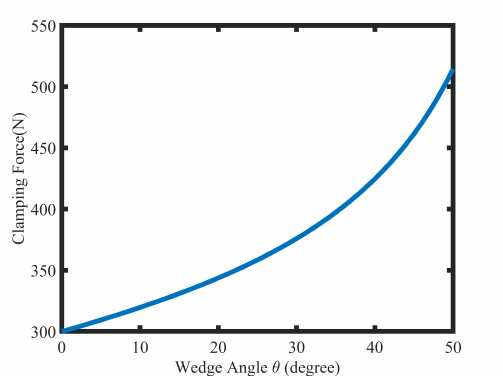
Figure 4. The relationship between the clamping force and the wedge angle.